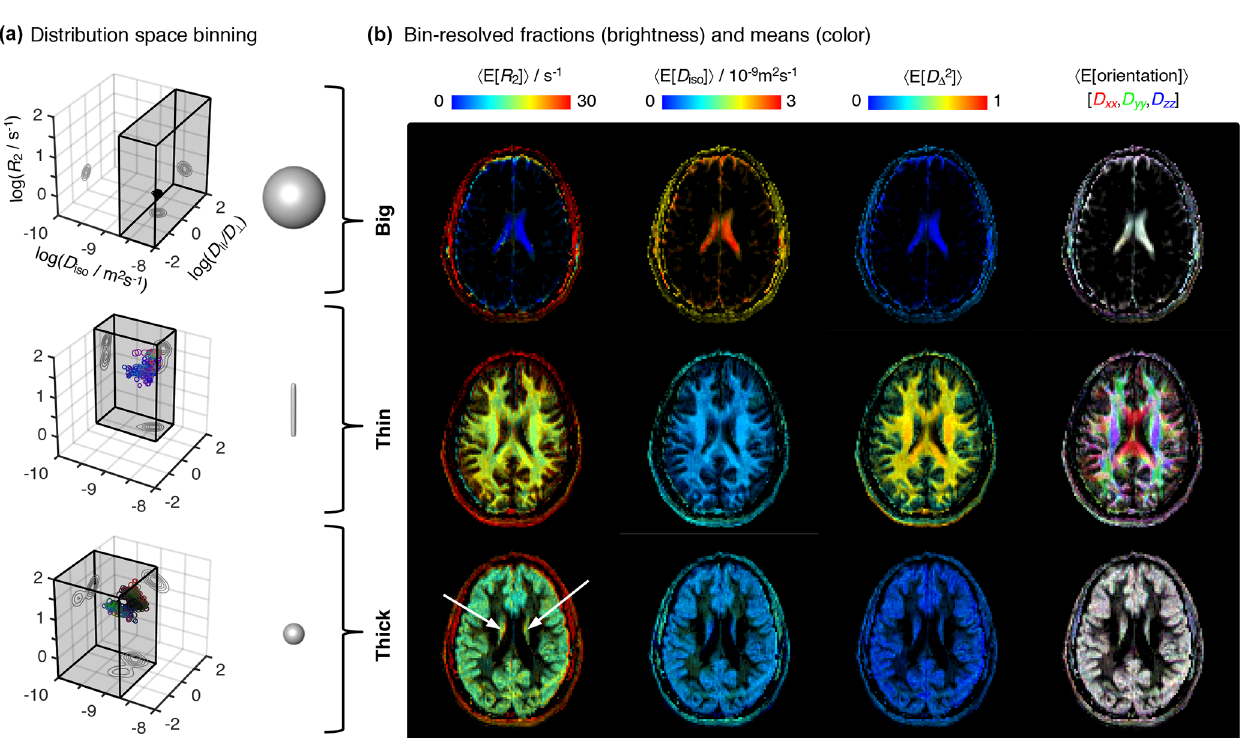
Figure 4. Parameter maps with bin-resolved means of the relaxation–diffusion distributions. (a) Division of the R 2 - D distribution space into different bins. The distribution space was separated into three bins (gray volumes) named “big”, “thin”, and “thick” that loosely capture the diffusion features of cerebrospinal fluid CSF, white matter WM, and gray matter GM, respectively. The 3D scatter plots display the nonpara- metric R 2 - D distributions corresponding to the CSF (top), WM (middle), and GM (bottom) voxels selected in Fig. 2. Superquadric tensor glyphs are used to illustrate the representative D captured by each bin. (b) Parameter maps of average per-bin means (color) of transverse relaxation rate (cid:104) E [ R 2 ](cid:105) , isotropic diffusivity (cid:104) E [ D iso ](cid:105) , squared anisotropy (cid:104) E [ D (cid:49) 2 ](cid:105) , and diffusion tensor orientation (cid:104) E[Orientation] (cid:105) . The orientation maps (column 4) are color-coded as [R,G,B] = [ D xx ,D yy ,D zz ] / max( D xx ,D yy ,D zz ), where D ii are the diagonal elements of laboratory-framed average diffusion tensors estimated from the various distribution bins. Brightness indicates the signal fractions corre- sponding to the big (row 1), thin (row 2), and thick (row 3) bins. The white arrows identify deep gray-matter